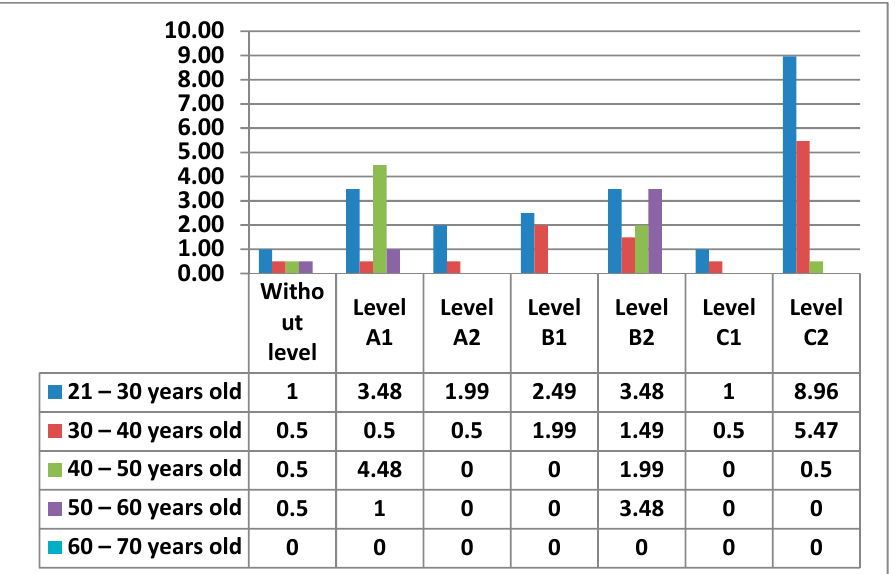
Figure 28. Digital competence in women by age in Area 5.